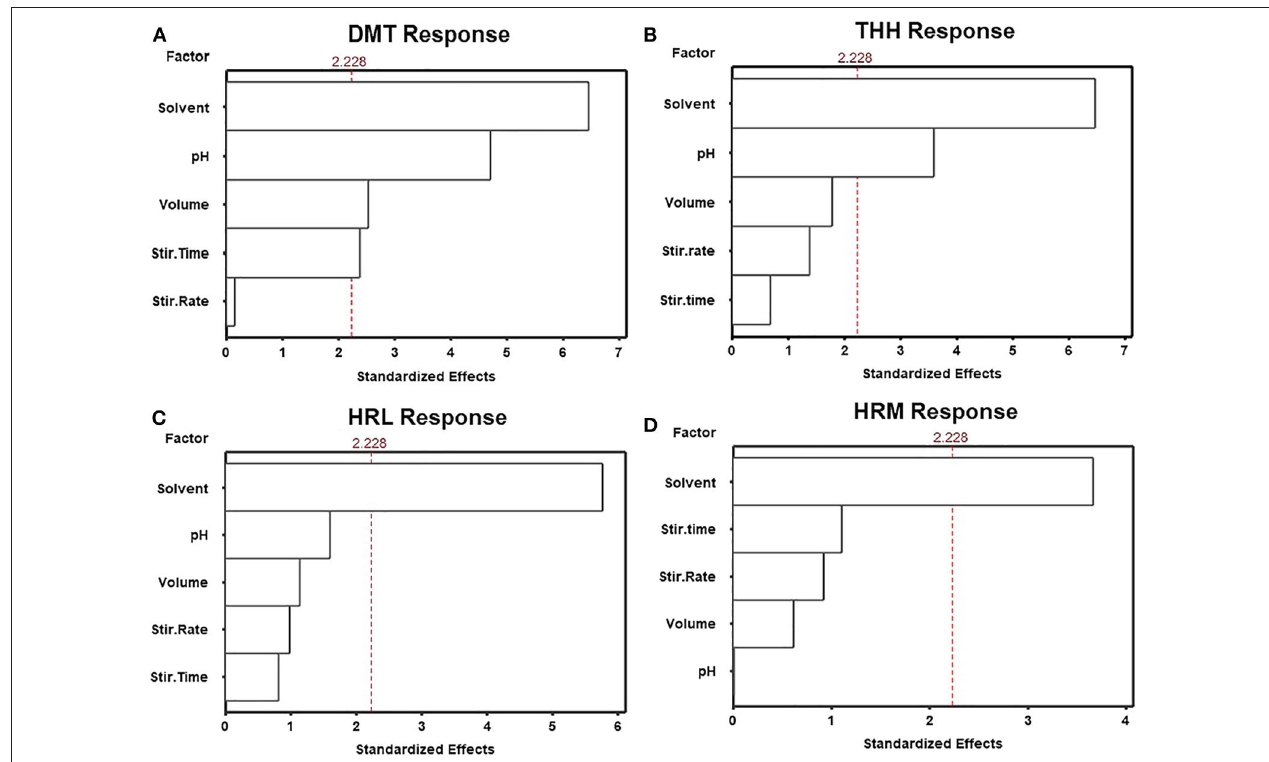
FIGURE 2 | Standardized main effect Pareto charts for the fractional factorial design of (A) dimethyltryptamine (DMT), (B) tetrahydroharmine (THH), (C) harmaline (HRL), and (D) harmine (HRM).